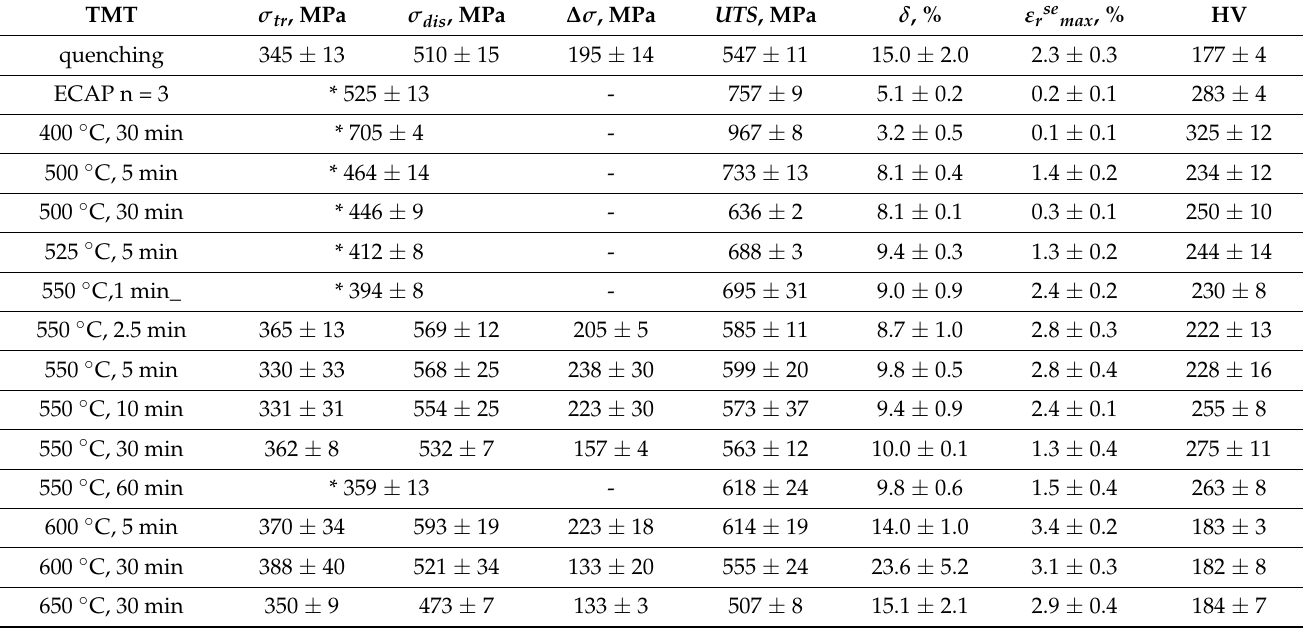
Table A1. The mechanical and functional properties of the Ti-18Zr-15Nb alloy after ECAP and